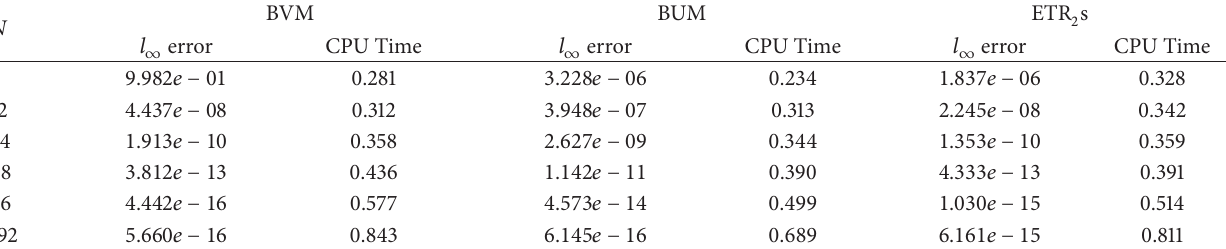
Table 2: Computational results for V = 3 for Example 5.1.